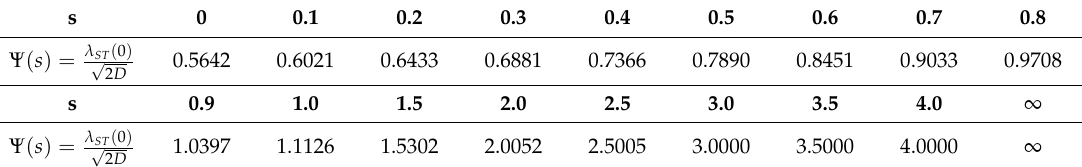
Table 2. The initial statistical failure rate (SFR) vs. its standard